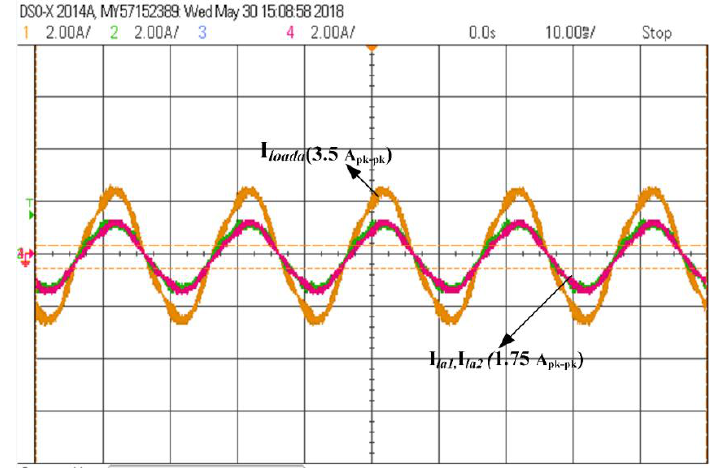
Figure 21. Output current of Inverter-1, Inverter-2 and load.